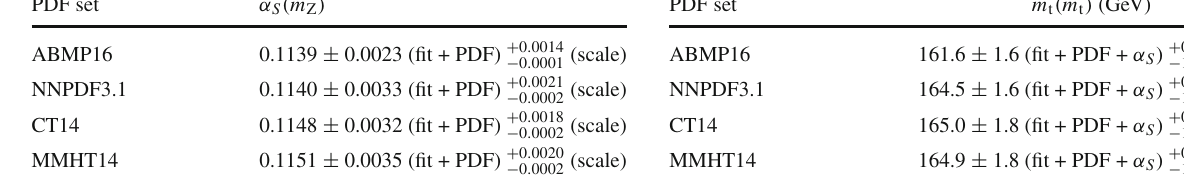
Fig. 11 Left: χ 2 versus α S obtained from the comparison of the mea- sured σ tt value to the NNLO prediction in the MS scheme using differ- ent PDFs (symbols of different styles). Right: α S ( m Z ) obtained from the comparison of the measured σ tt value to the theoretical prediction using different PDF sets in the MS scheme. The corresponding value of